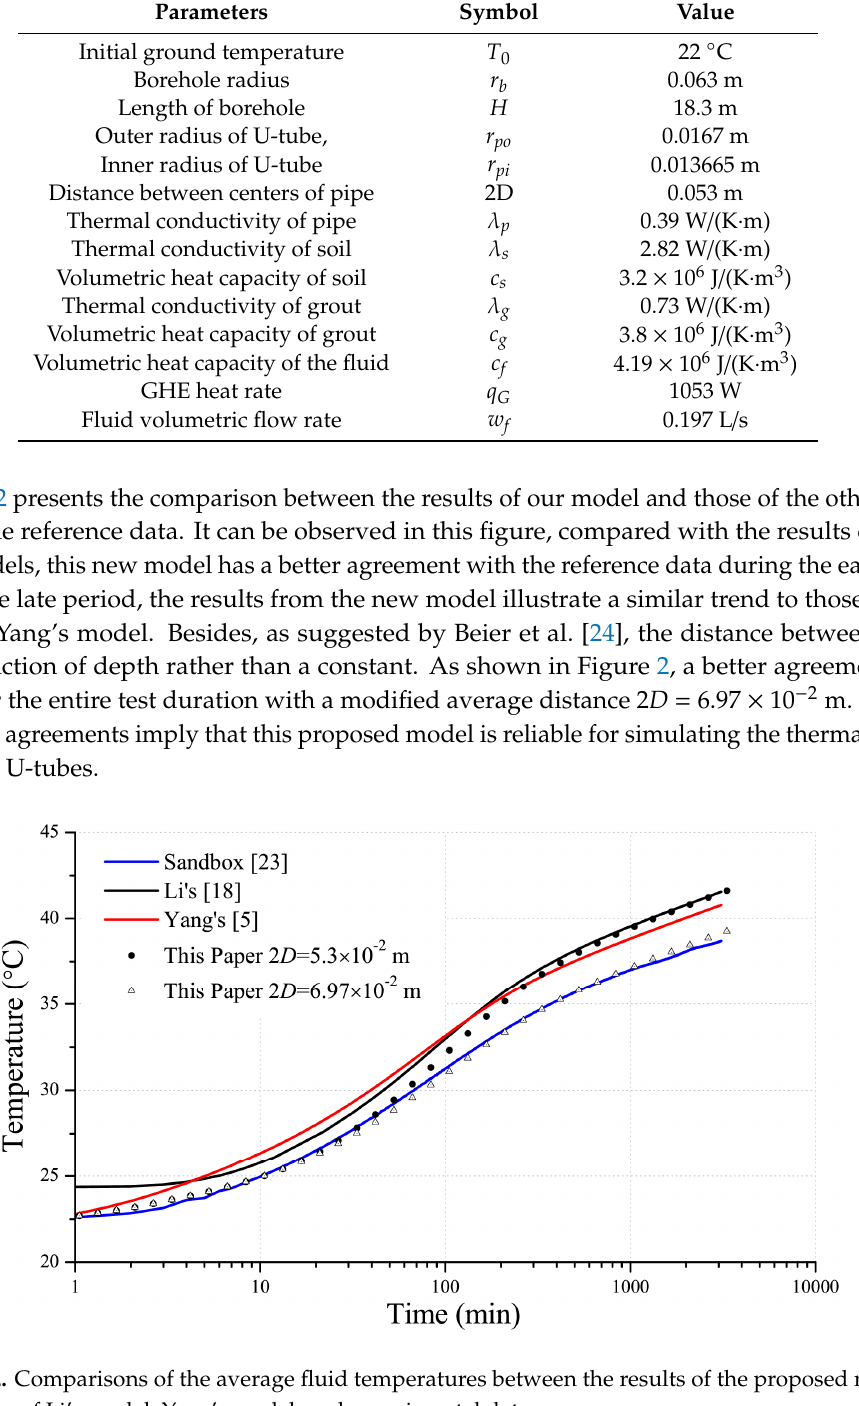
Figure 2. Comparisons of the average fluid temperatures between the results of the proposed model and those of Li’s model, Yang’s model, and experimental